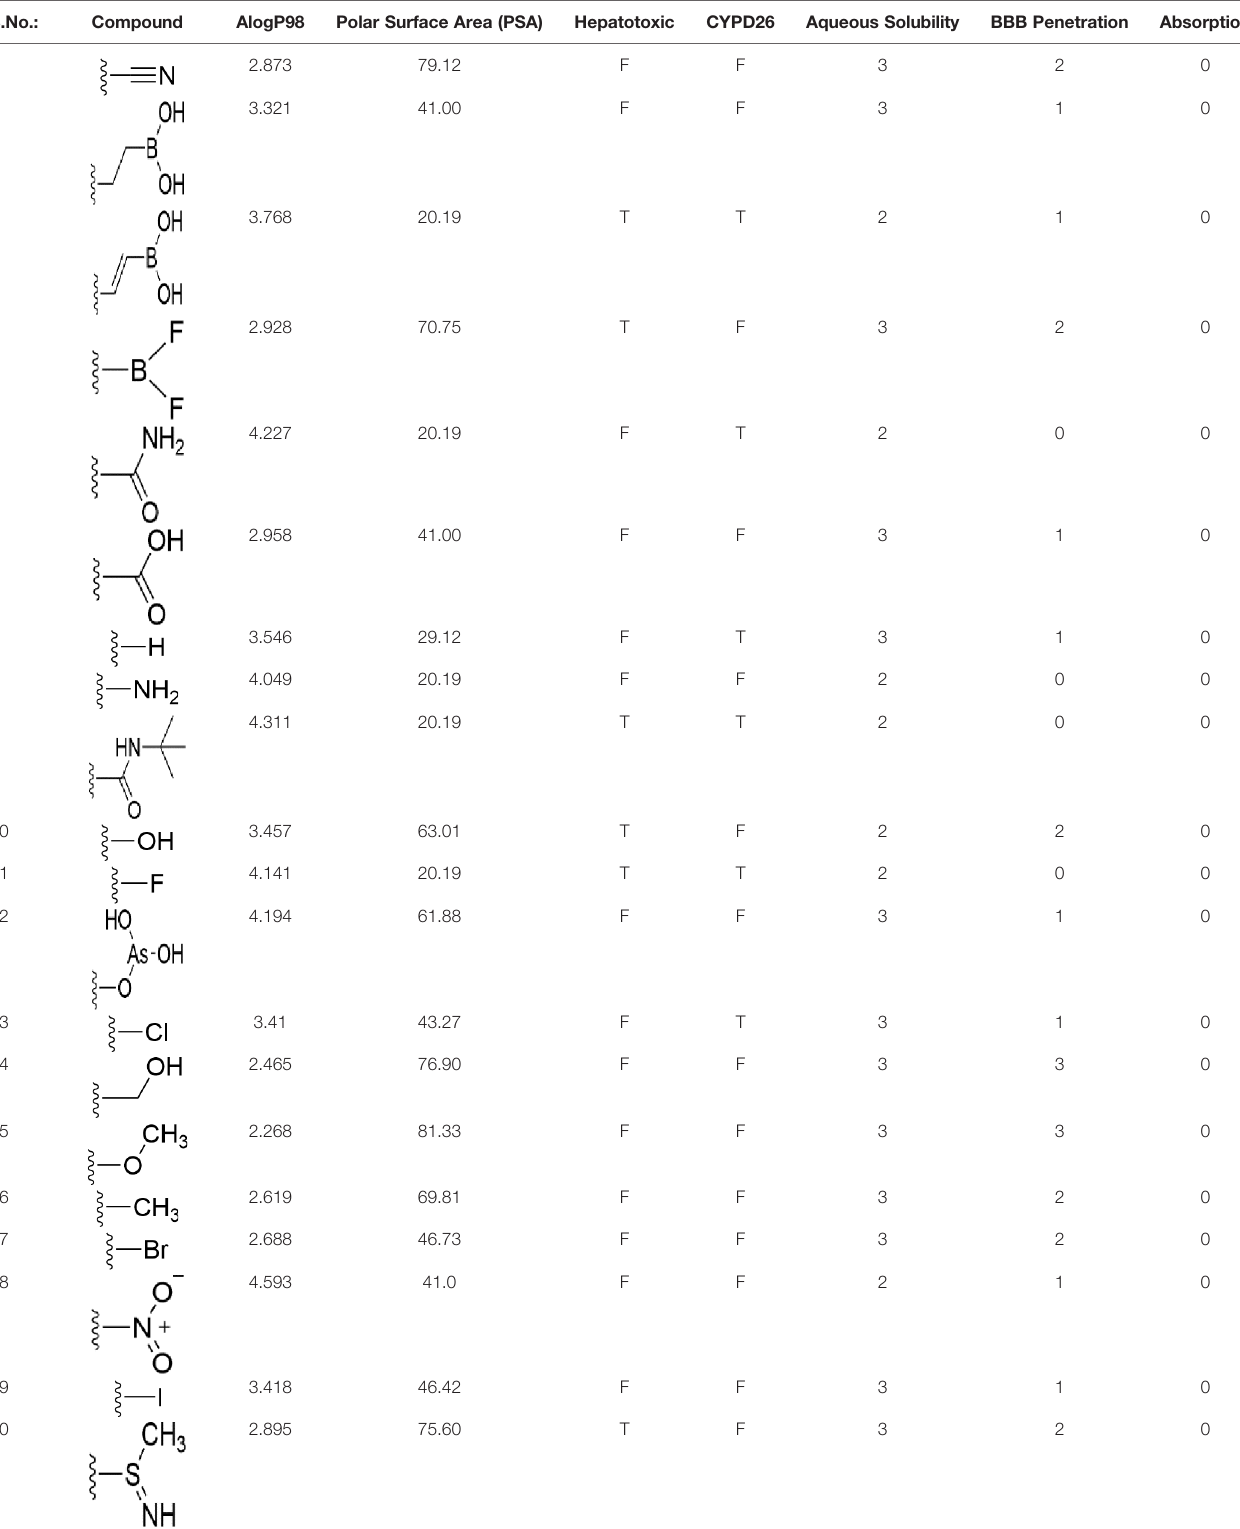
TABLE 2 | ADMET prediction of the screened bio isosteric molecules.